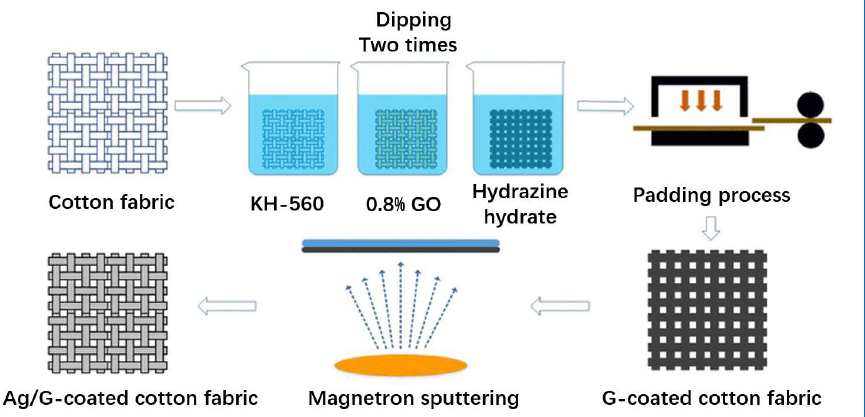
Figure 6. Preparation process of Ag/G-coated cotton fabric via PVD approach [70].